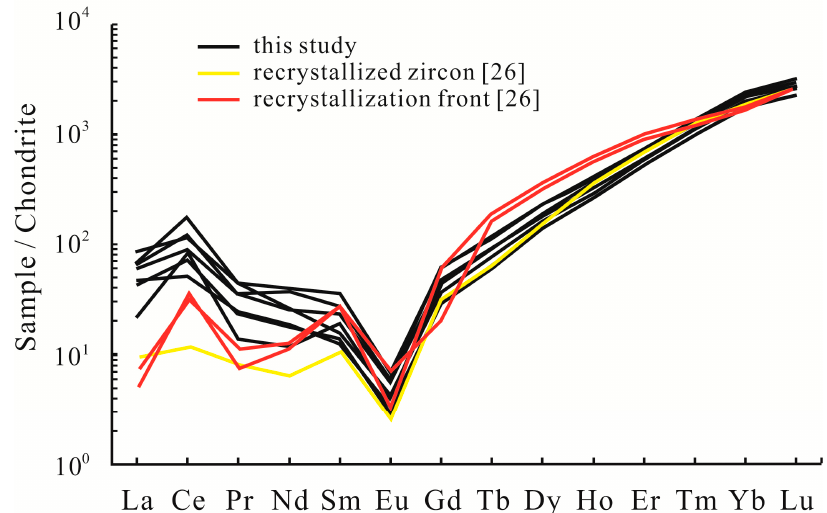
Figure 5. Chondrite-normalized rare earth element (REE) patterns for zircon from the quartz–allanite vein from study area and the partially to fully recrystallized zircon from high-grade metagranitoids from Queensland, Australia [26].